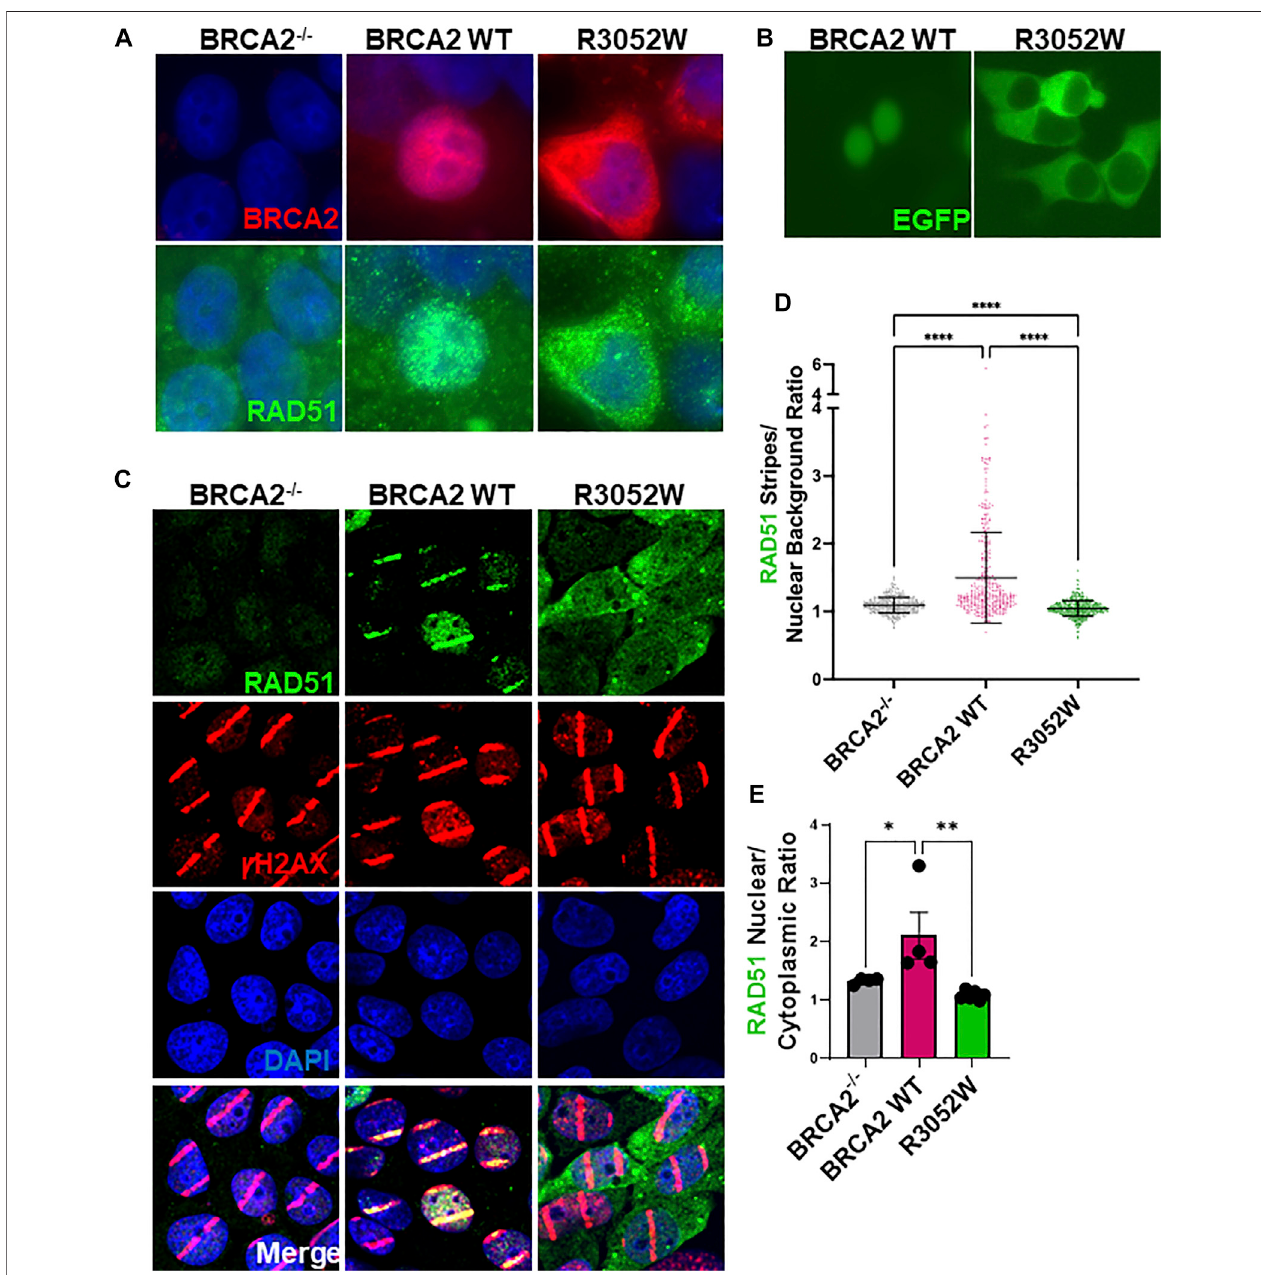
FIGURE3| TheR3052Wproteinlocalizestothecytosol. (A) Immuno fl uorescentlocalizationofBRCA2inuntreated BRCA2knockoutcells(BRCA2 − / − ),andstable cell lines expressing either BRCA2 WT or R3052W. Representative images of 2XMBP-BRCA2 (red, anti-MBP), RAD51 (green), and nuclei (blue). (B) Live images of BRCA2 knockout cells expressing either BRCA2 WT or R3052W fused to GFP at the N-terminus. (C) Representative immuno fl uorescence images of laser micro- irradiation experiments in BRCA2 knockout cells stably expressing BRCA2 WT or R3052W. DNA damage (stripes) are depicted in red (gammaH2AX), green (RAD51),andnucleiinblue(DAPI). (D) Quanti fi cationofRAD51 fl uorescenceintensityindamageareas(stripes)overthebackgroundinnon-irradiatedareasofrespective laser micro-irradiated nuclei. Each data point represents a single analyzed nucleus, while the solid line is a mean value ± SD (Kruskal-Wallis test with Dunn ’ s multiple comparisonposthoctest;**** p value < 0.0001). (E) Quanti fi cationofRAD51intensityinthenuclearandcytoplasmiccompartments.Eachdatapointrepresentsasingle analyzed area (220.16 microns × 220.16 microns), while bars represent mean ± SD (one-way ANOVA with Holm- Š ídák ’ s multiple comparisons post hoc test, * p -value < 0.05; ** p -value < 0.01).